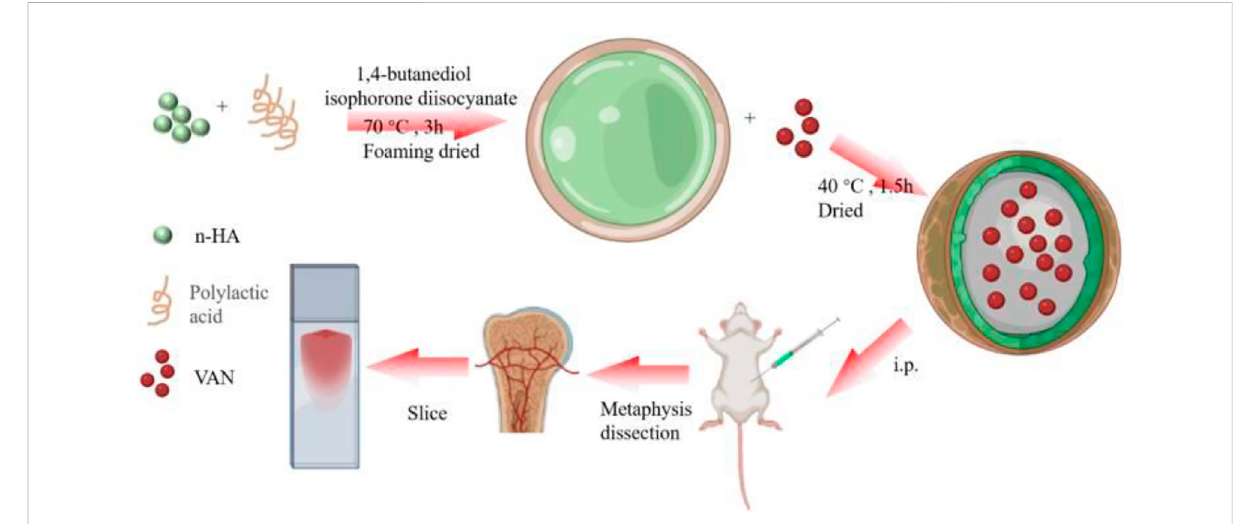
FIGURE 5 nHA-PLA-VAN system assembling and study strategy. Reproduced with permission from Lv et al. (2022). Copyright © 2022 The